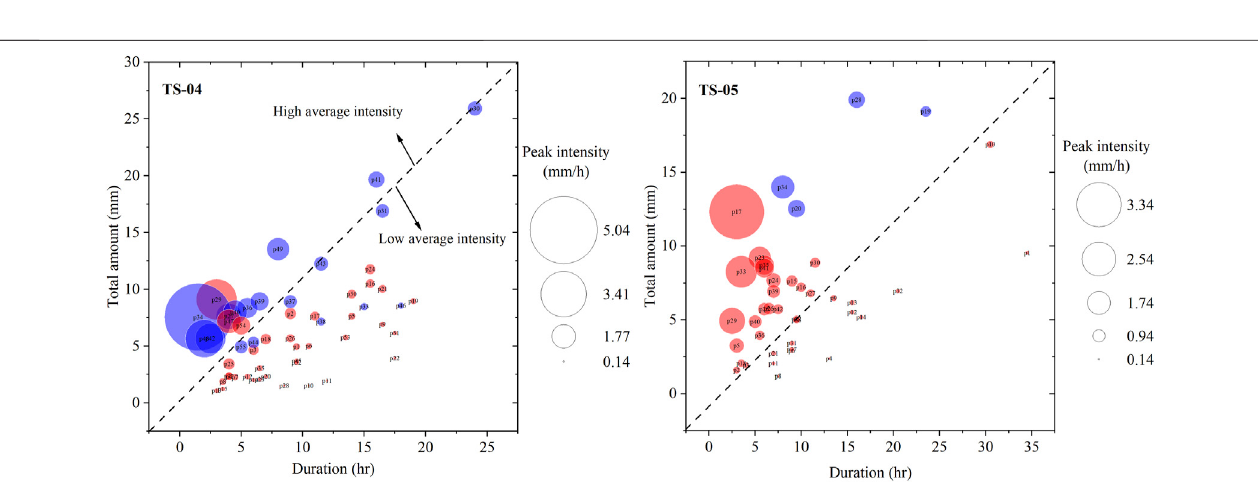
FIGURE 10 | Bubble plots of the intensity of rainfall in the summer and the response of soil moisture at TS-04 and TS-05 sites.